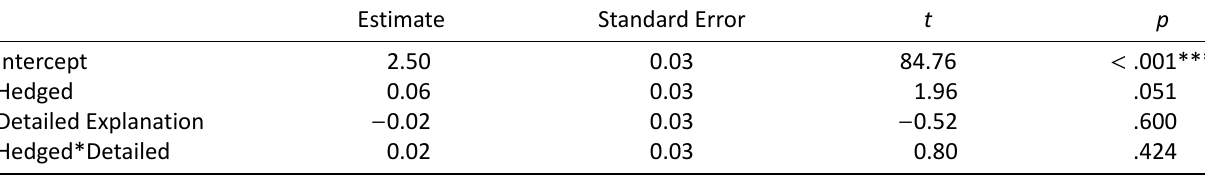
Table 2. General linear model predicting information acceptance by correction style condition.